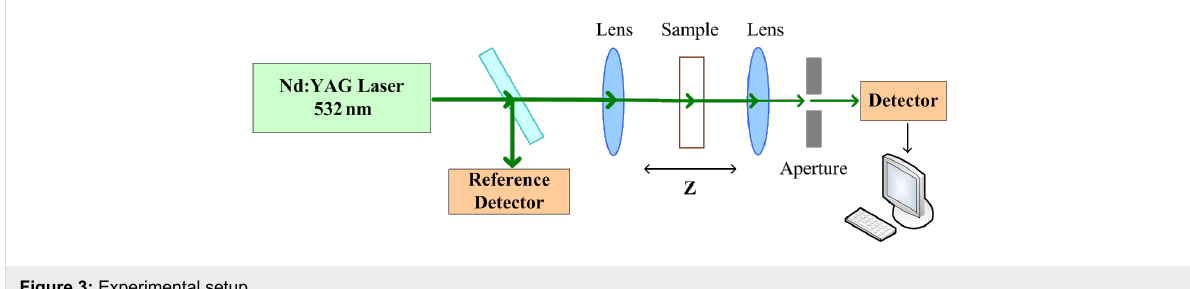
Figure 3: Experimental setup.